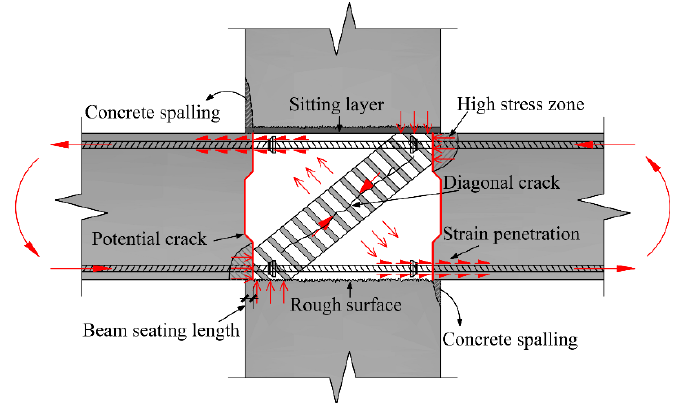
Figure 4. Force mechanism of the monolithic precast joint.